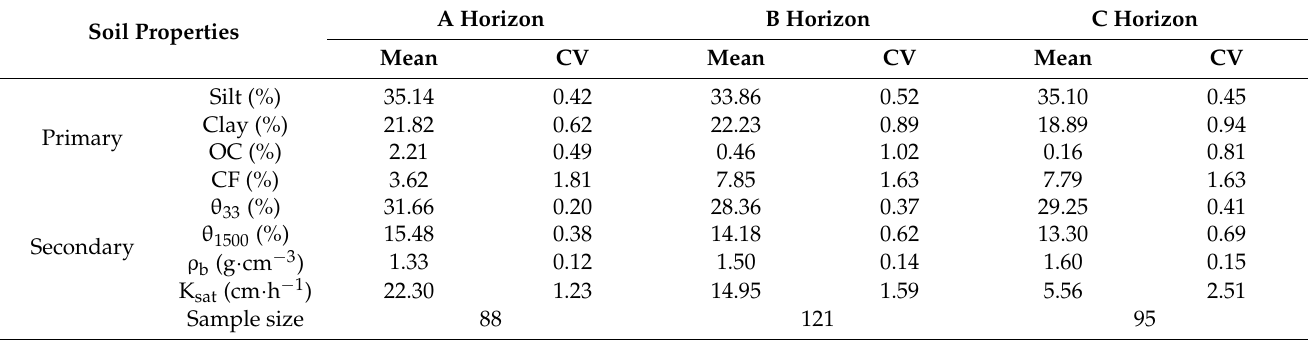
Table 2. Statistics of soil properties; CV, coefficient of